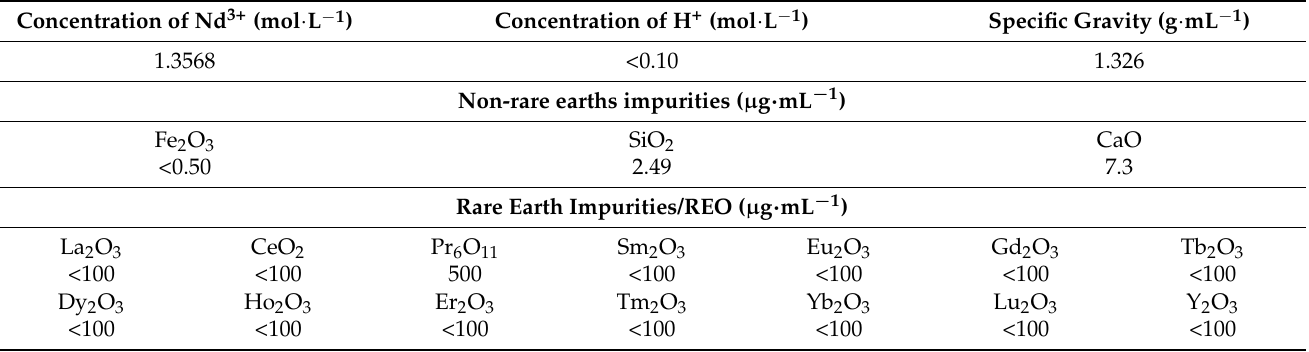
Table 1. Content of the high purity solution of NdCl 3 .